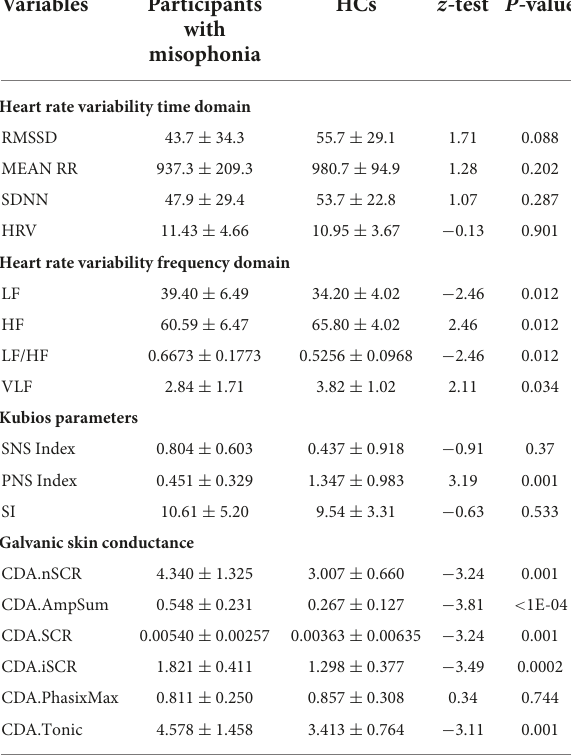
TABLE 3 Baseline HRV and GSC